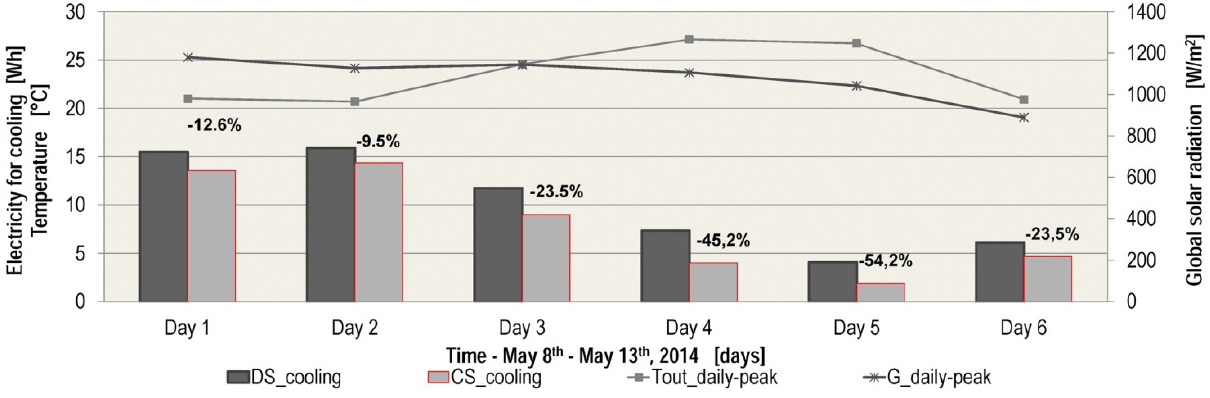
Figure 10. Daily energy requirement for cooling of CS and DS with varying daily weather parameters, i.e. , outdoor dry bulb temperature and global solar